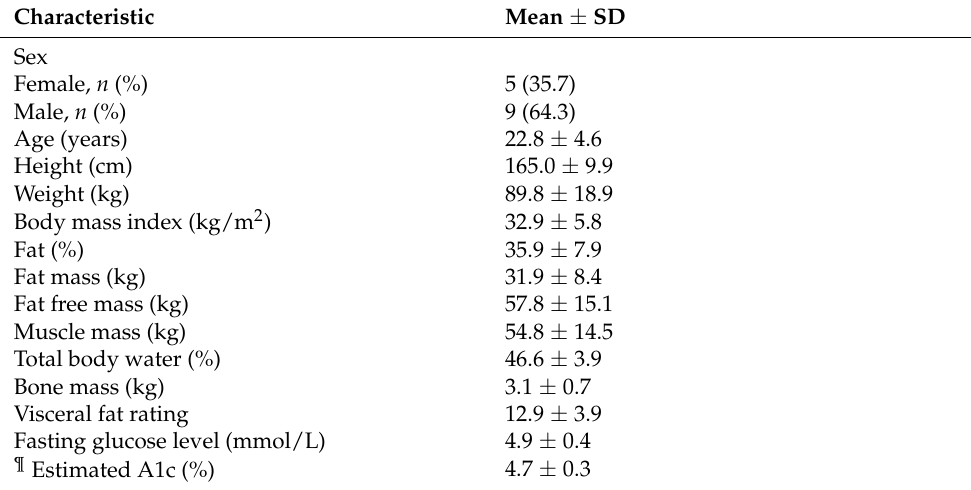
Figure 1. Consort flow chart. Table 2. Characteristics of the study